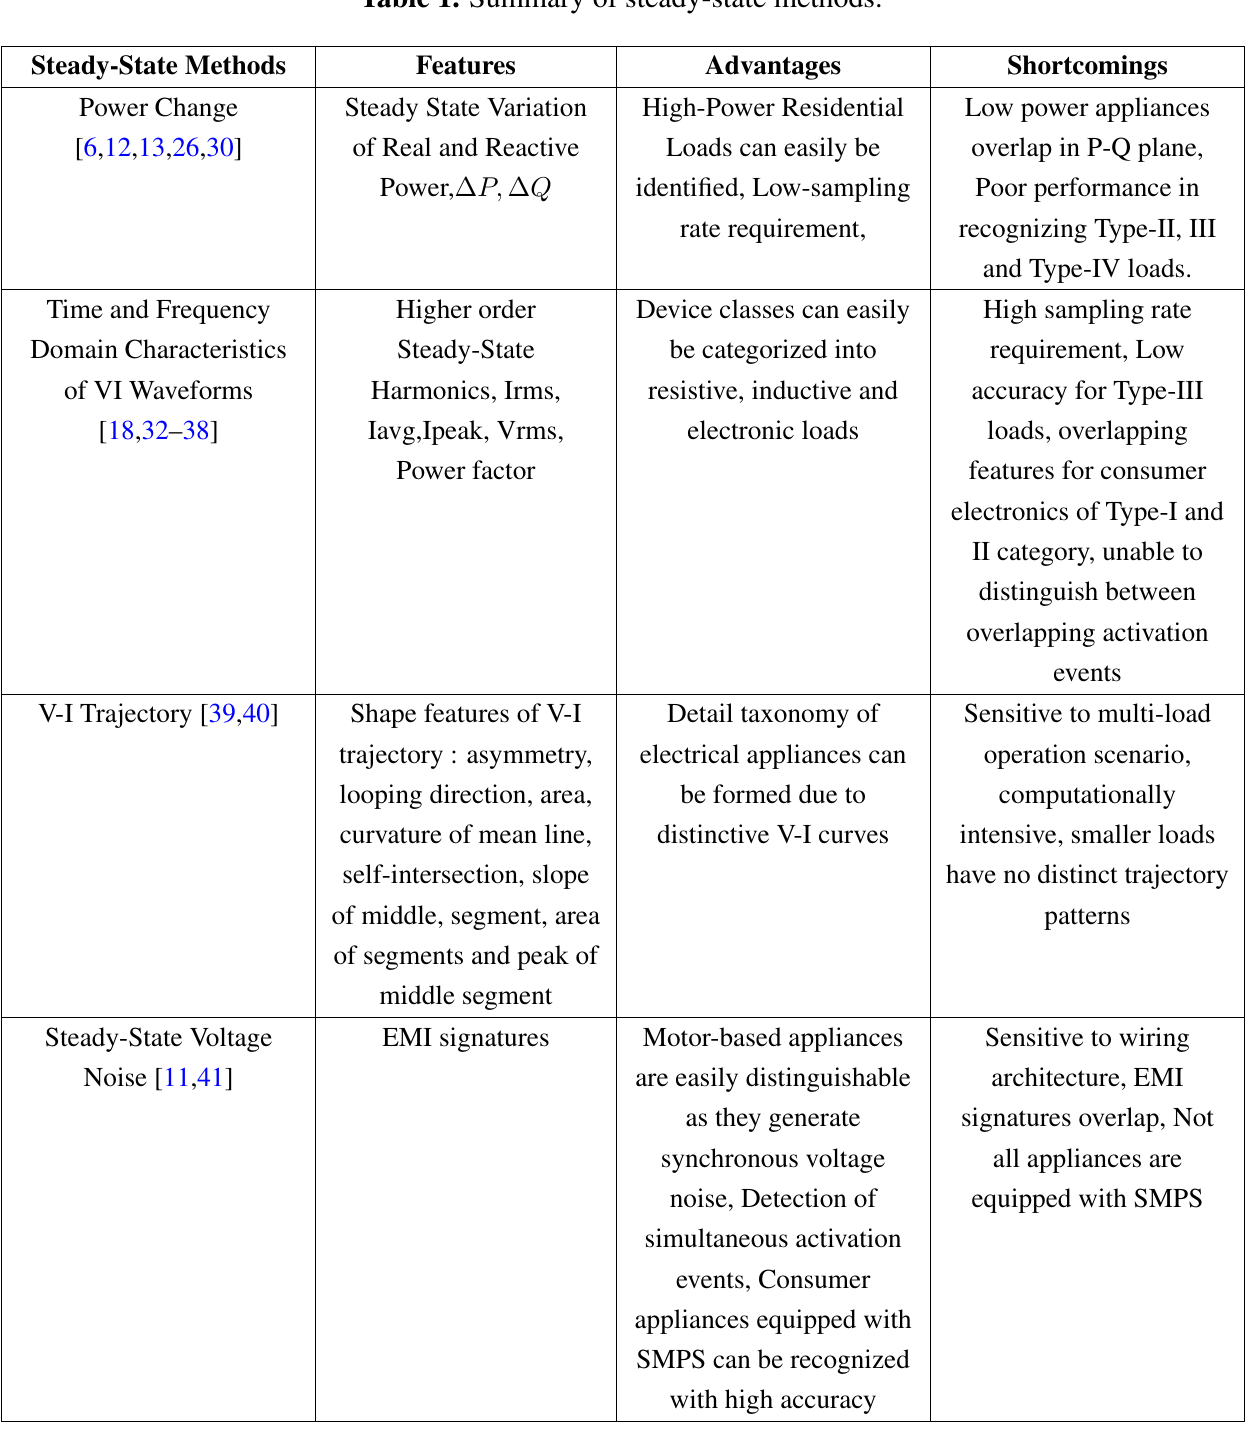
Table 1. Summary of steady-state